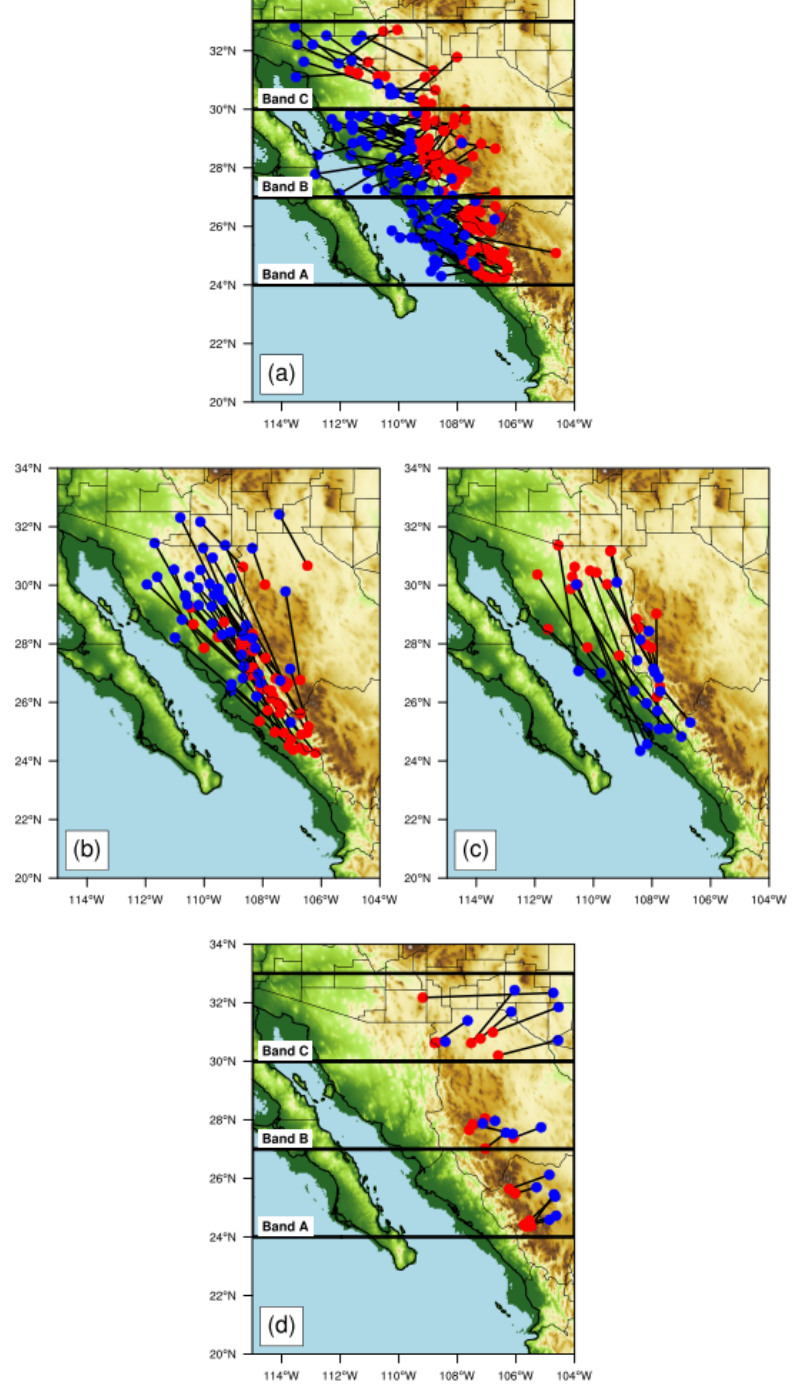
Figure 9. MCS trajectories used to calculate propagation. Trajectory 1 ( a ). Trajectory 2 for ( b ) Propa- gating Northward and ( c ) Propagating Southward. Trajectory 3 ( d ). Red (blue) point corresponds to MCS initiation (dissipation). The black line represents the border between the latitudinal bands called A, B, and